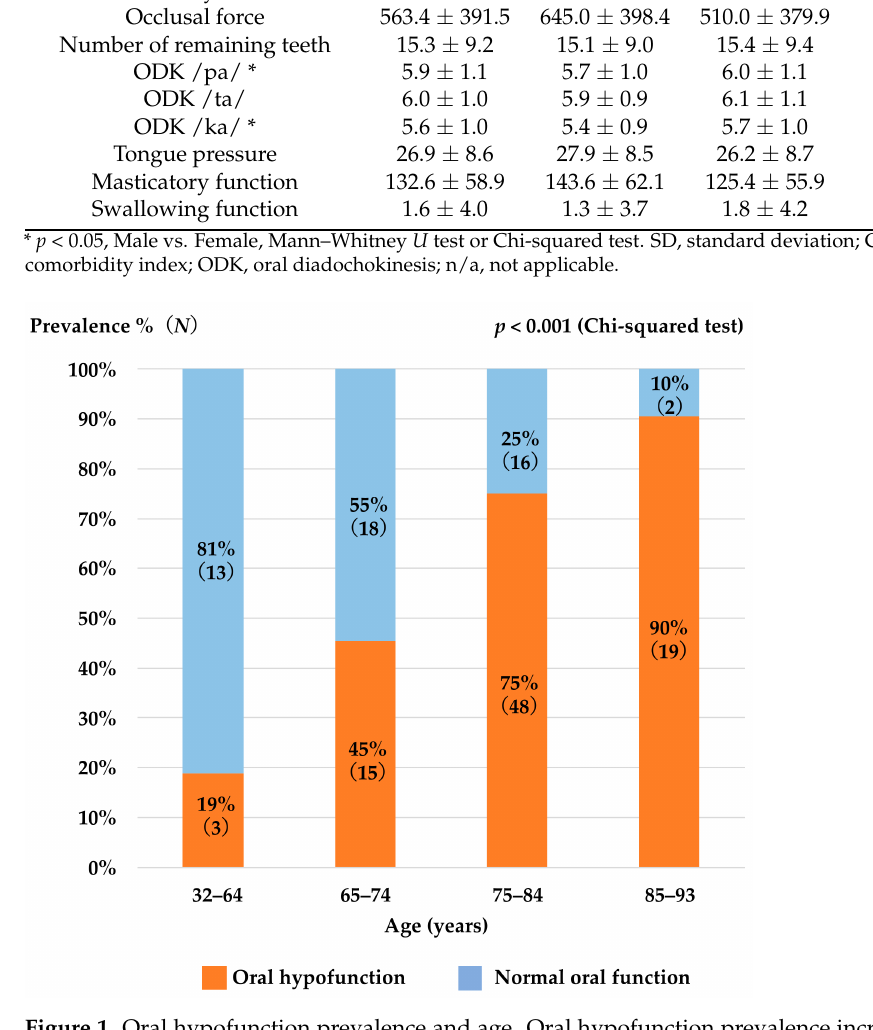
Figure 1. Oral hypofunction prevalence and age. Oral hypofunction prevalence increased signifi- cantly with age zone ( p < 0.001, Chi-squared